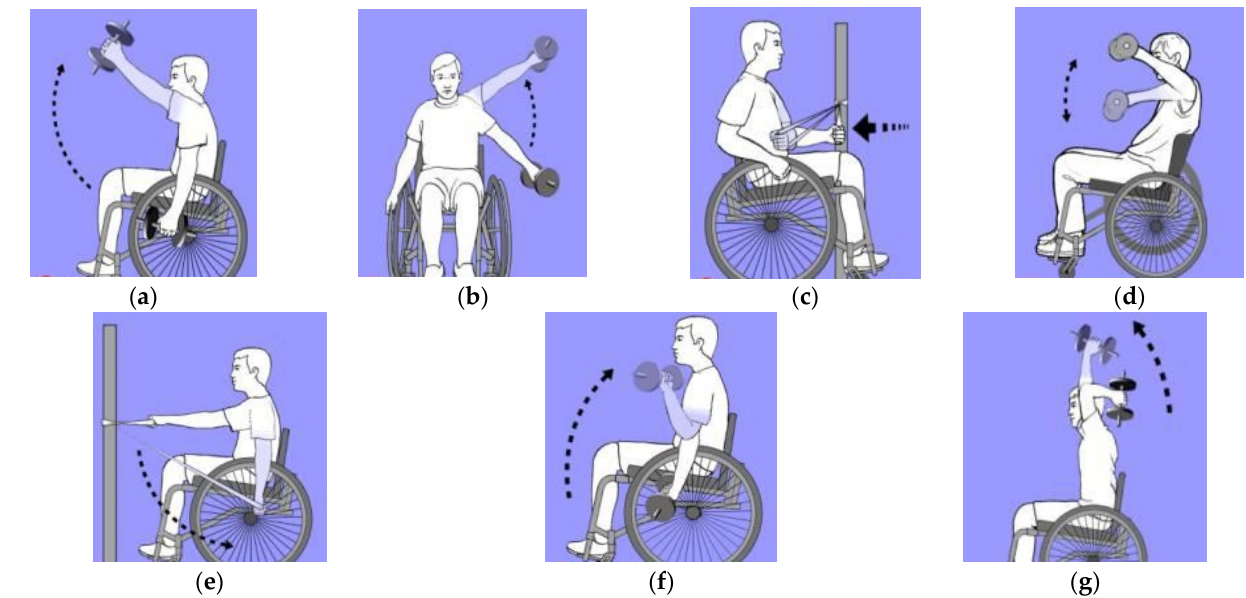
Figure 1. Physical activities used to rehabilitate spinal cord injuries (SCI) patients: ( a ) Shoulder flexion; ( b ) Shoulder abduction; ( c ) Internal rotation; ( d ) External rotation; ( e ) Extension; ( f ) Elbow flexion; ( g ) Elbow extension [28].